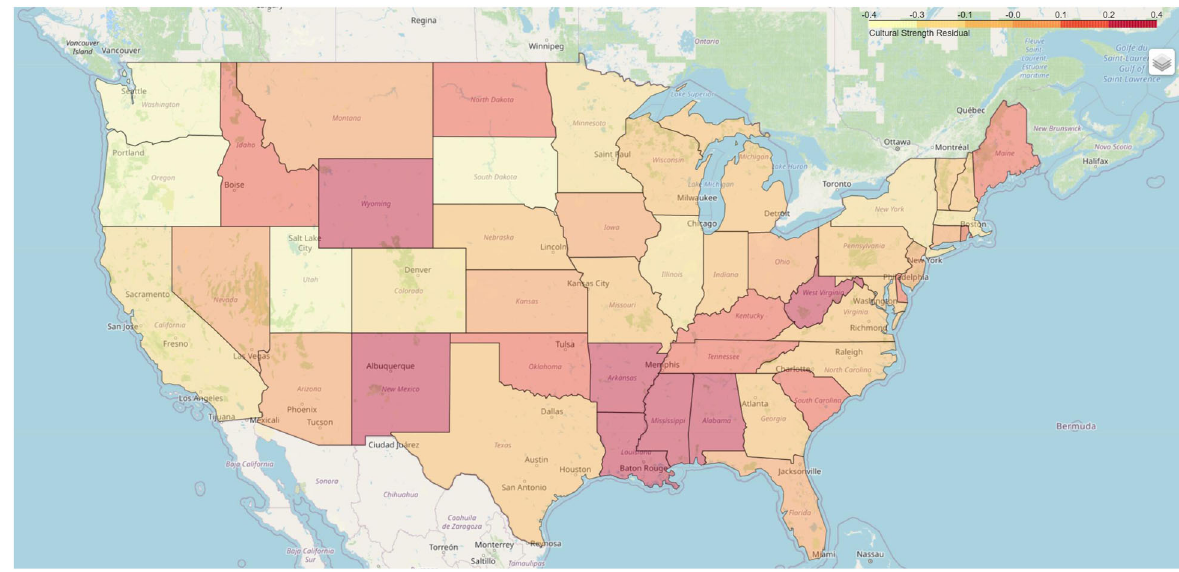
Fig. 5 US states by degree of cultural strength (computed on “ pros ” ). The cultural strength metric used in this fi gure is the residual obtained from regressing Cultural strength on Firm Glassdoor reviews to remove the mechanical correlation existing between the two variables.